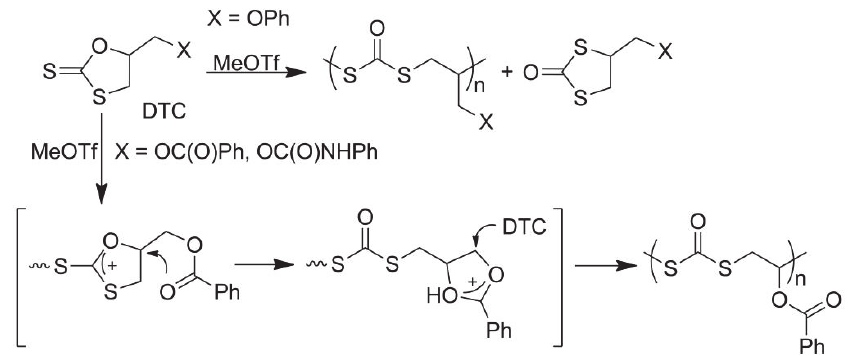
Figure 12. Controlling the reaction path of a CROP of dithiocarbonates using Neighboring Group Participation (NGP).